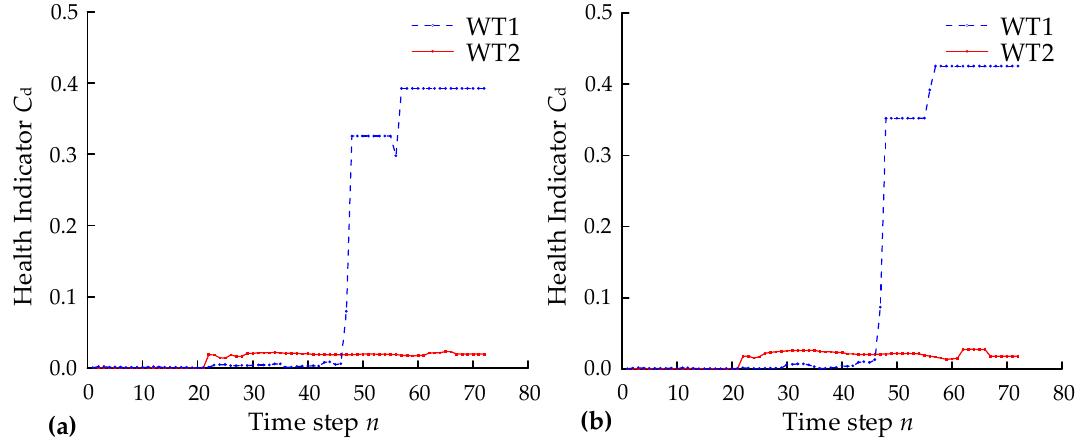
Figure 12. Effect of sampling frequency on the health indicators of the wind turbine: ( a ) sampling frequency is 0.2 Hz, total time step n = 73; ( b ) sampling frequency is 0.1 Hz, total time step n = 73.